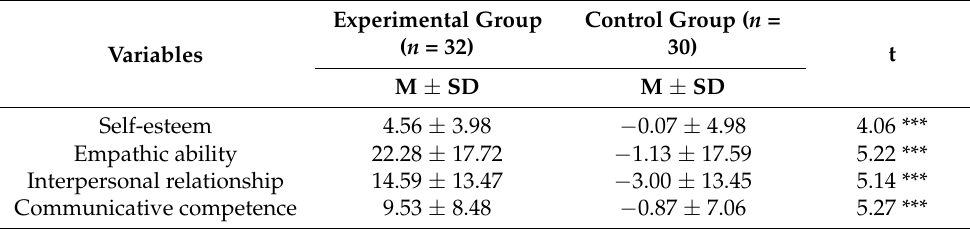
Table 4. Comparison of dependent variables between experimental group and control group ( N =